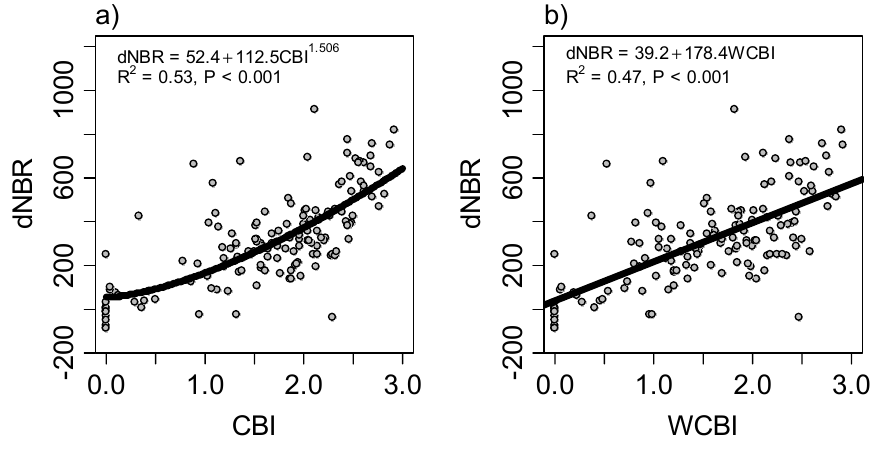
Figure 2. Regression models for the WCBI data set (n = 146) between ( a ) dNBR and CBI, ( b ) dNBR and WCBI, ( c ) RdNBR and CBI, and ( d ) RdNBR and WCBI. Using